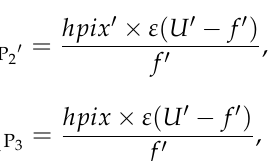
Figure 5. The geometric relationship between the combination of the camera and laser rangefinder and the target plane in clockwise direction: ( a ) horizontal length transformation; ( b ) vertical propor- tional relationship.